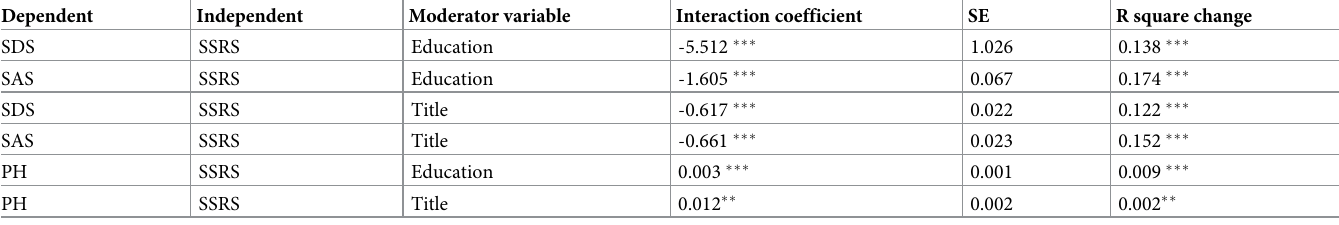
Table 4. The moderating effect of physician education and title on SSRS, SDS, SAS, and PH.